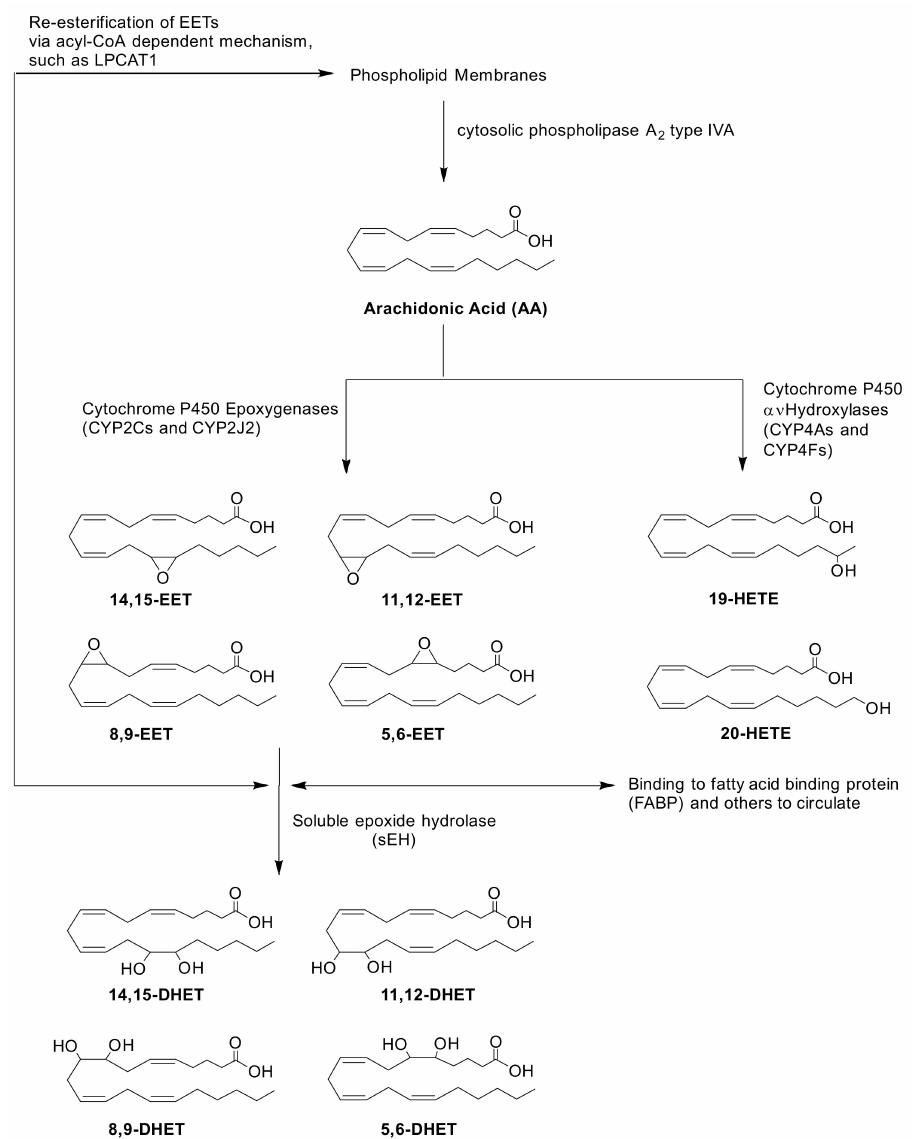
Figure 1. Biosynthesis and biodegradation of EETs via CYP pathways. AA is hydrolyzed from the phospholipid membrane upon activation of cPLA 2 a (encoded by PLA2G4A ). Oxidation of AA by CYPs require NADPH-CYP Oxidoreductase ( POR ) to transfer electrons and initiate their catalytic cycle. CYP epoxygenases, CYP2Cs and CYP2J2, mediate the biosynthesis of four regioisomers of cis -EETs. Once formed, EETs can either be incorporated back into the phospholipid membrane via acyl-CoA such as lysophosphatidylcholine acyltransferase 1 ( LPCAT1 ), bound to other proteins in circulation or hydrolyzed by sEH (encoded by EPHX2 ) to generate